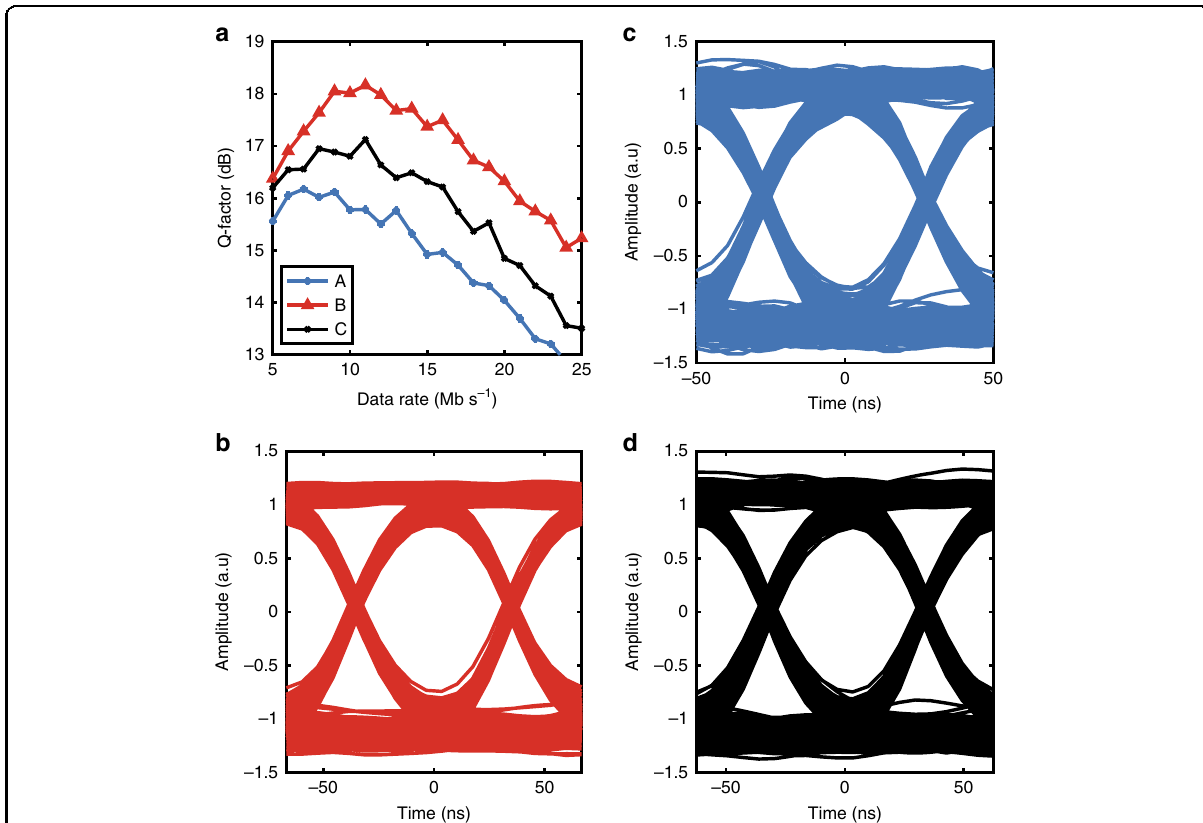
Fig. 4 Communication system demonstration. a The measured Q -factor of the link as a function of data rate for the three samples tested. Each of the Q -factors shows a similar pro fi le: an initial increase due to the penalty caused by the coupling capacitors at the transmitter and receiver 46 followed by a peak, and then consistent degradation due to the low level of light recovered from the devices and its ratio to the noise equivalent power of the photodetector. Nevertheless, to show the performance of the devices under test, we illustrate the eye diagrams for b sample A at 20 Mb/s, c sample B at 15 Mb/s, and d sample C at 16Mb/s. Each of these clearly shows a clear eye opening at the centre point of the symbol period and a high degree of symmetry within both rise and fall